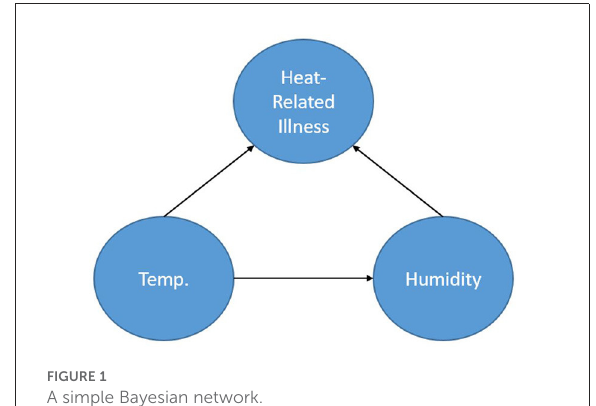
FIGURE1 A simple Bayesian